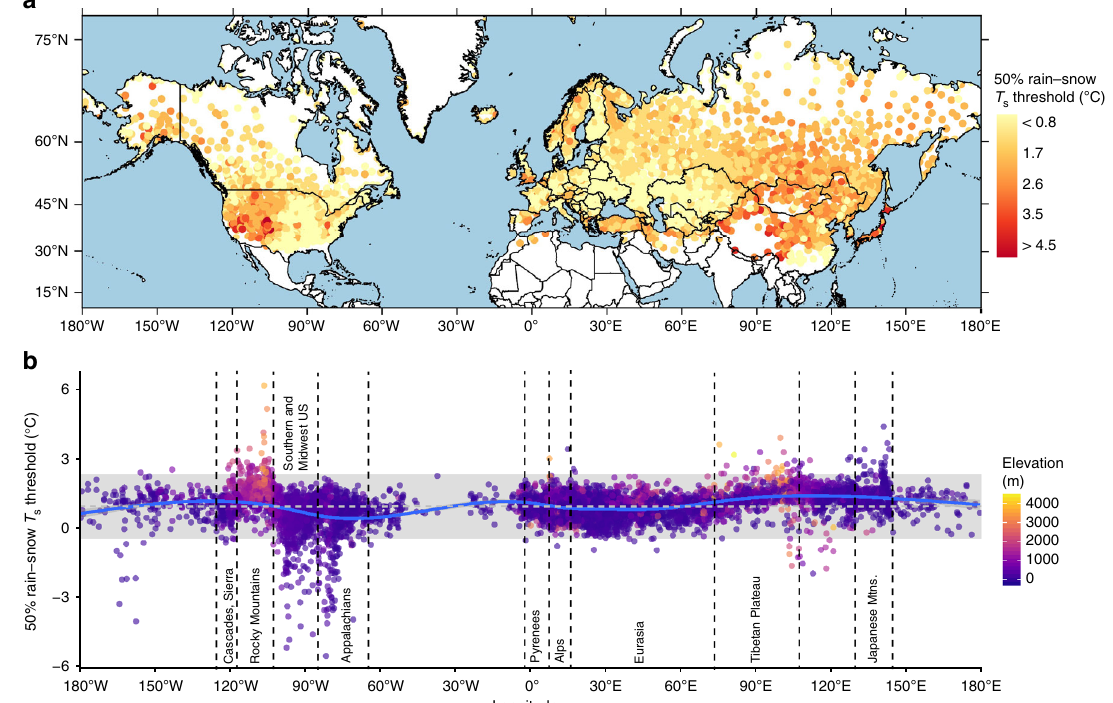
Fig. 1 The observed 50% rain – snow T s threshold over the Northern Hemisphere for 6883 land stations from 1978 to 2007. Each point represents one station and only stations with a suf fi cient number of snowfall events were analyzed. a Thresholds mapped by station location. b Thresholds plotted by station longitude. The horizontal dashed line represents the Northern Hemisphere mean threshold (1.0 °C), the shaded gray box covers thresholds within ±2 standard deviations of the mean, and the blue line is a generalized additive model fi t to the threshold data by longitude. Regions of interest are denoted by text within vertical dashed